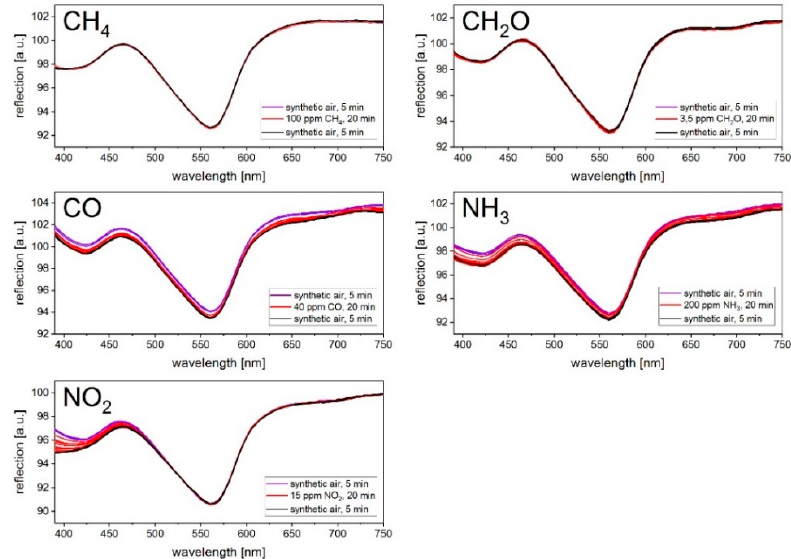
Figure 8. Cross-sensitivities of the Cu-PAN complex on PE foil to 100 ppm CH 4 , 3.5 ppm CH 2 O, 40 ppm CO, and 15 ppm NO 2 in synthetic air and a relative humidity of 40% at room temperature. Recording of 15 measurement cycles with a time lag of 2 min, respectively.